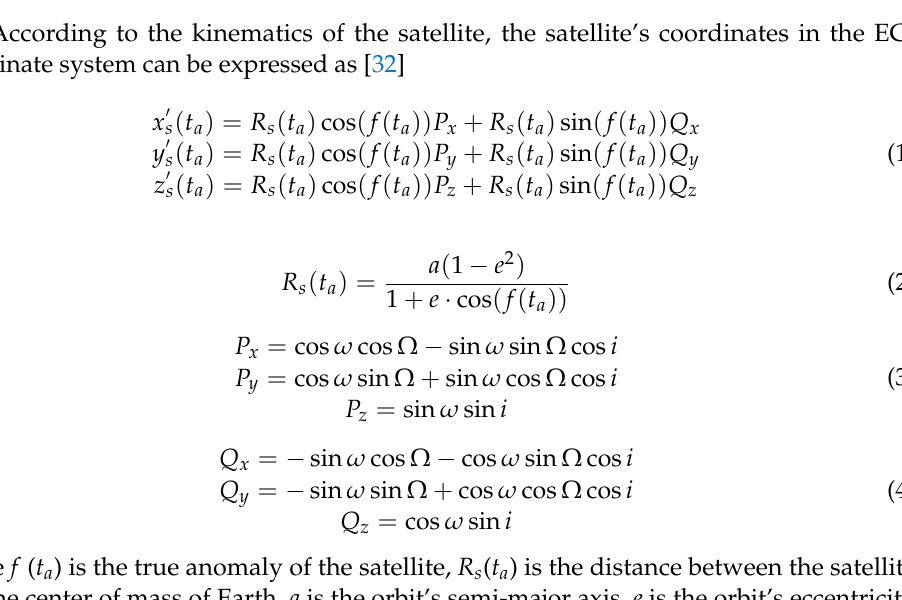
Figure 1. MEO SAR-GMTI